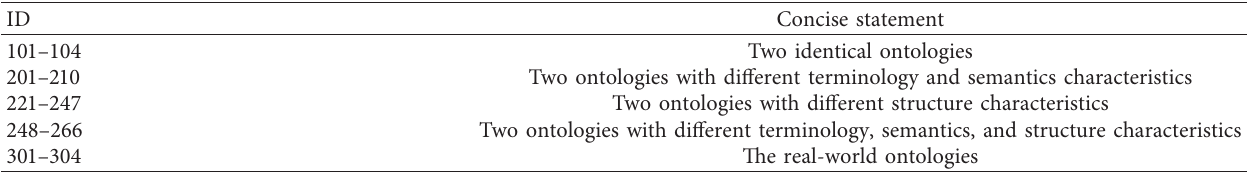
Table 1: The concise statement for the benchmark track.